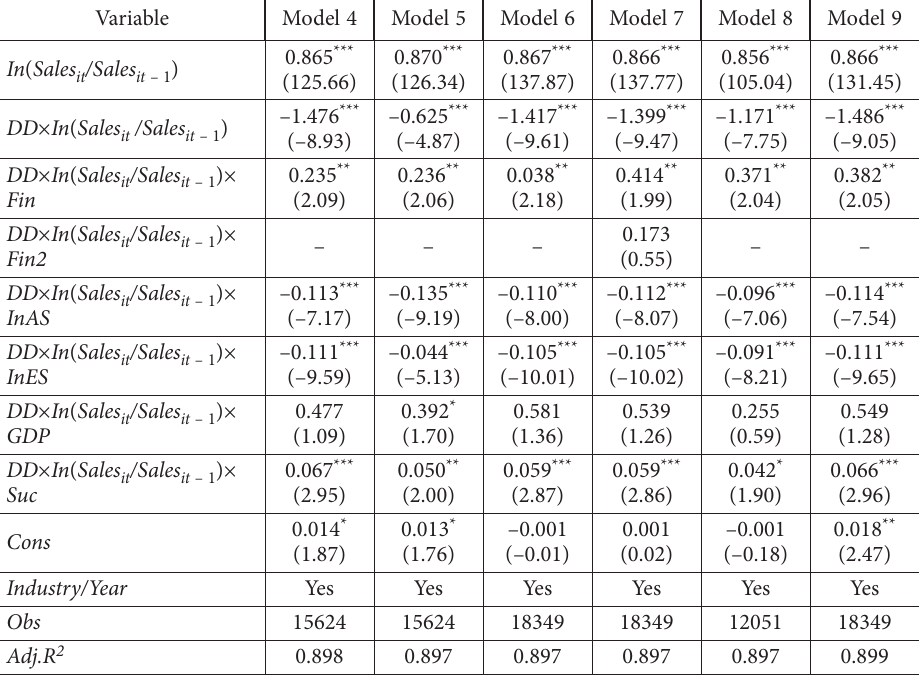
Table 4. Results of endogeneity and other robustness